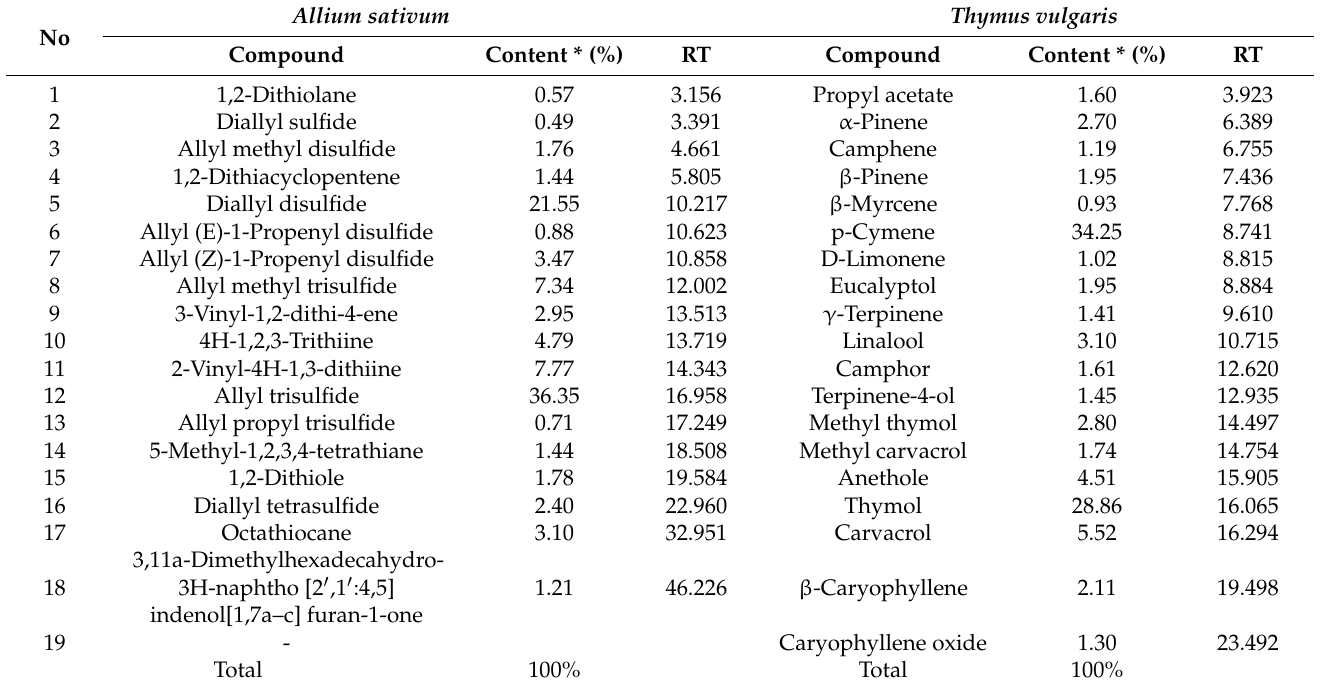
Table 3. Chemical compositions of the Allium sativum and Thymus vulgaris essential oils.